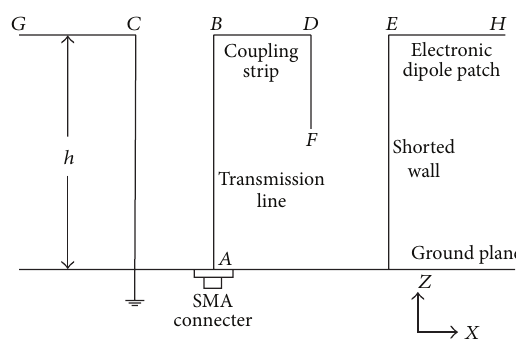
Figure 2: Schematic diagram of ME dipole antenna.